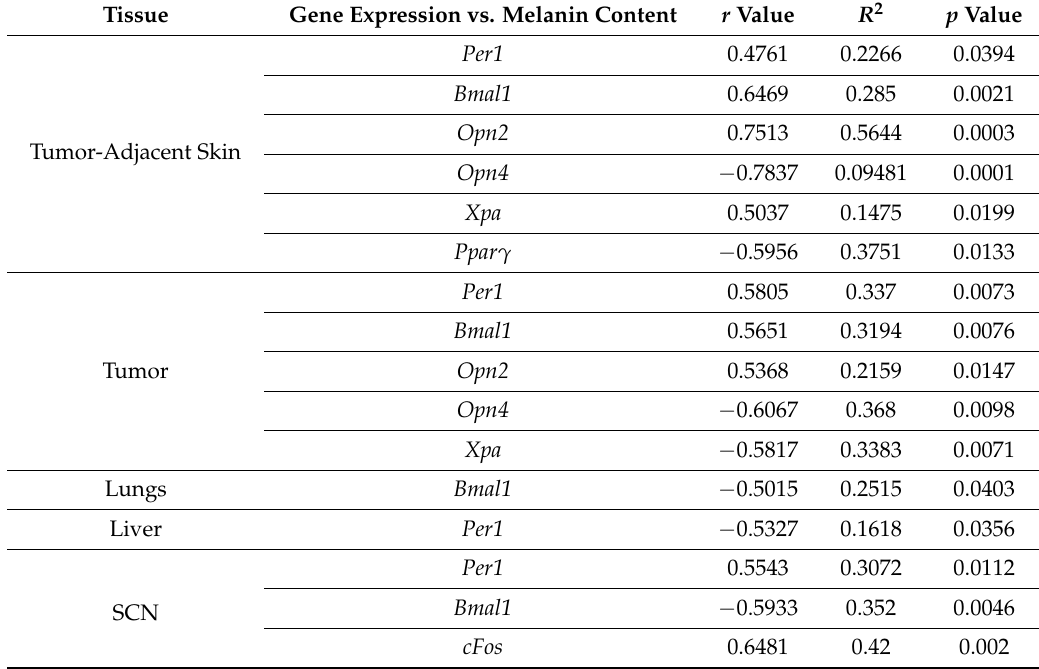
Table 1. Genes whose expression values correlate with melanin content of matched tumor-bearing mice. Tissue Gene Expression vs. Melanin Content